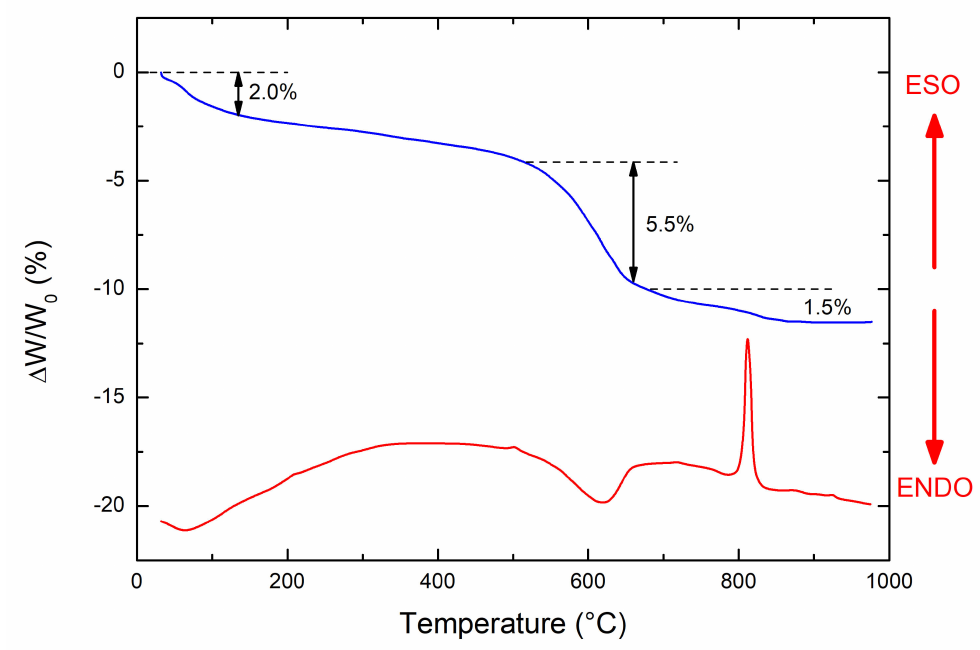
Figure 3. Thermogravimetric analysis (TGA) (in blue and differential thermal analysis (DTA) (in red) curves of the pristine garnierite powder